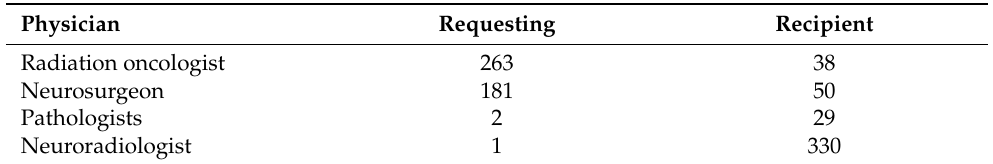
Table 1. Summary table of the role of the physicians attending our nMTB, divided into who pro- posed the case (requesting) and to whom questions were addressed (recipient).